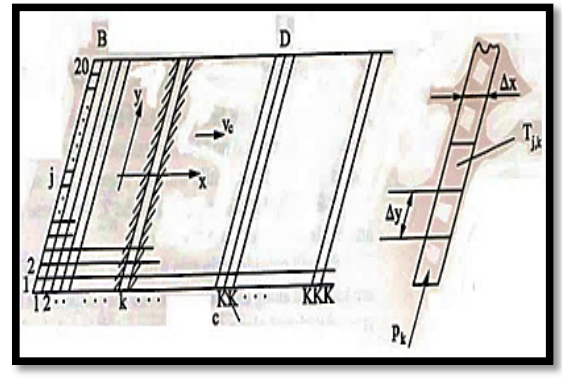
temperatures in the chip